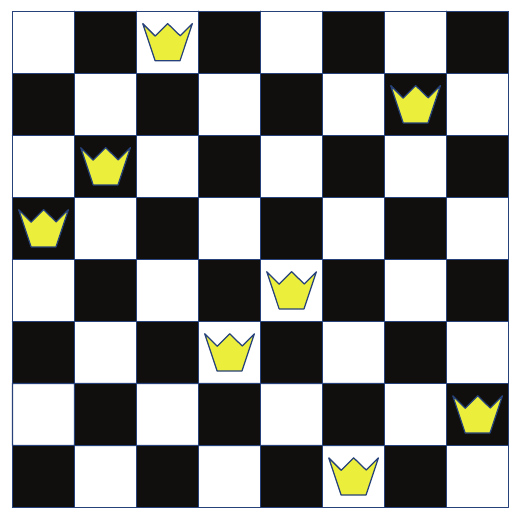
Figure 3: Example of a 6 × 6 instance for the